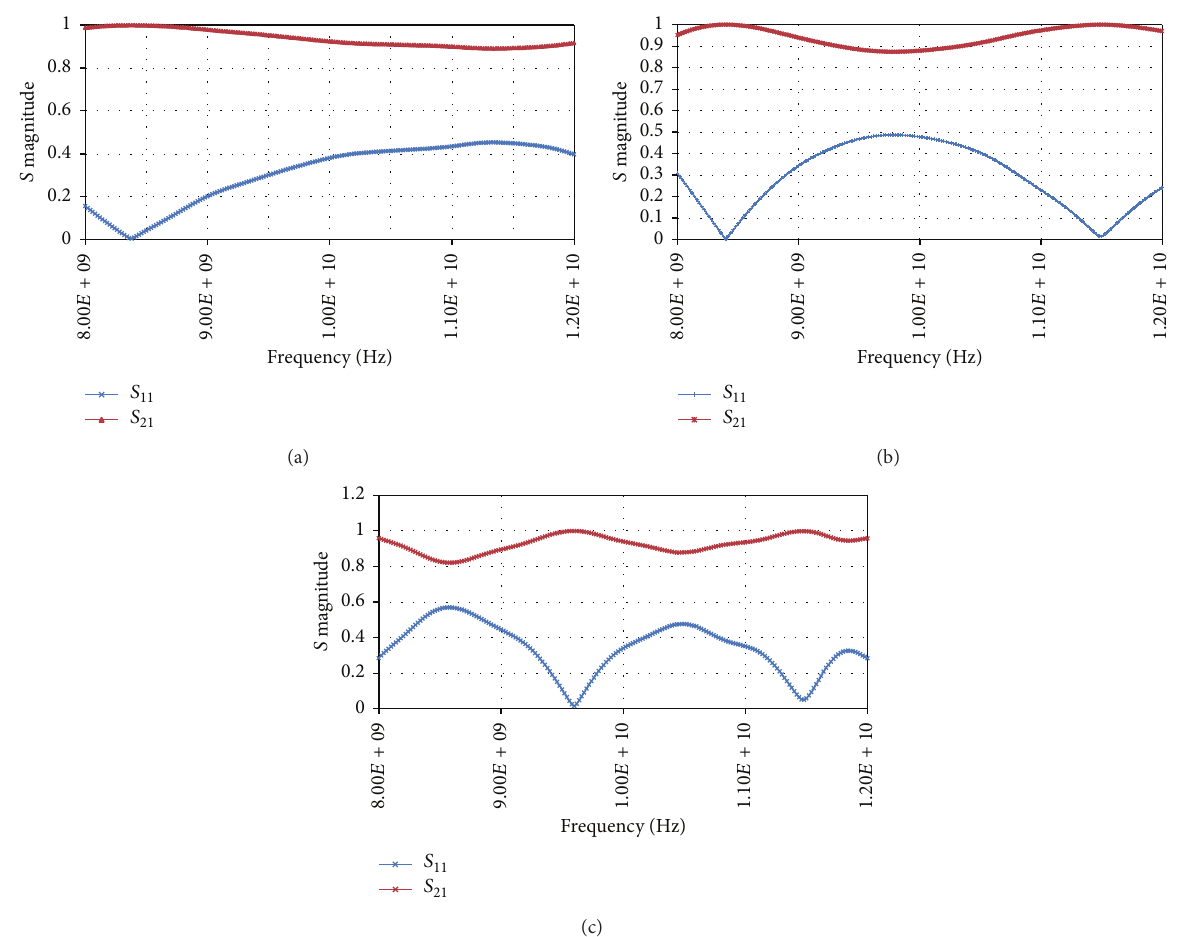
Figure 1: FEM simulated magnitude of 𝑆 11 and 𝑆 21 for 15 mm, 30 mm, and 50 mm PTFE samples, respectively.